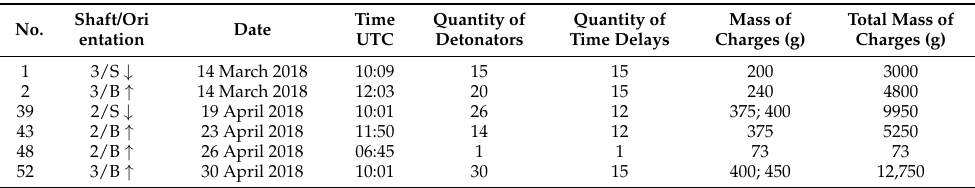
Table 2. Main parameters of the chosen blasts that are mentioned in this